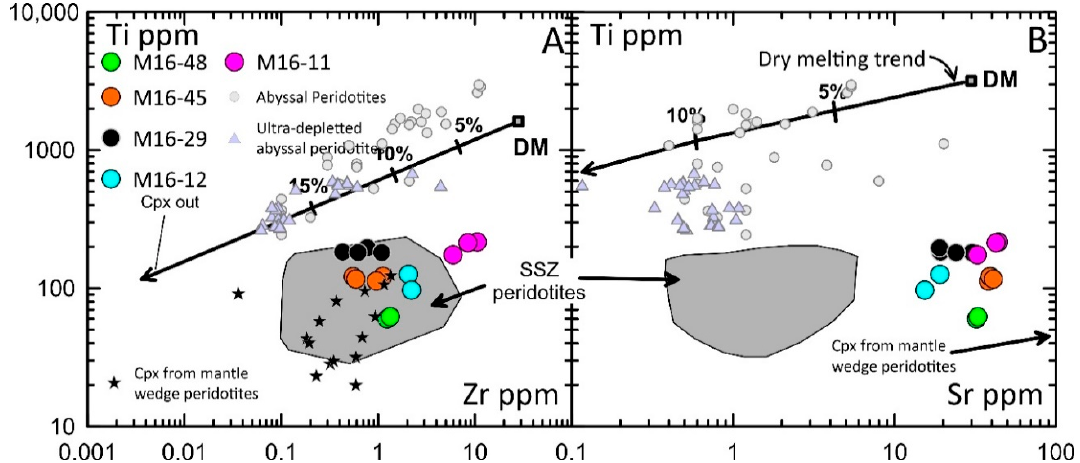
Figure 9. Ti, Zr ( A ), and Sr ( B ) (ppm) abundances in clinopyroxenes. Fields of SSZ peridotite clinopyroxene from [57,58,63], clinopyroxene in abyssal peridotites [56] and ultra-depleted abyssal peridotites from [39], and clinopyroxene in mantle-wedge peridotites [13] are used for comparison. Black line—DM dry melting trend at polybaric fractional melting in spinel facies after [57].